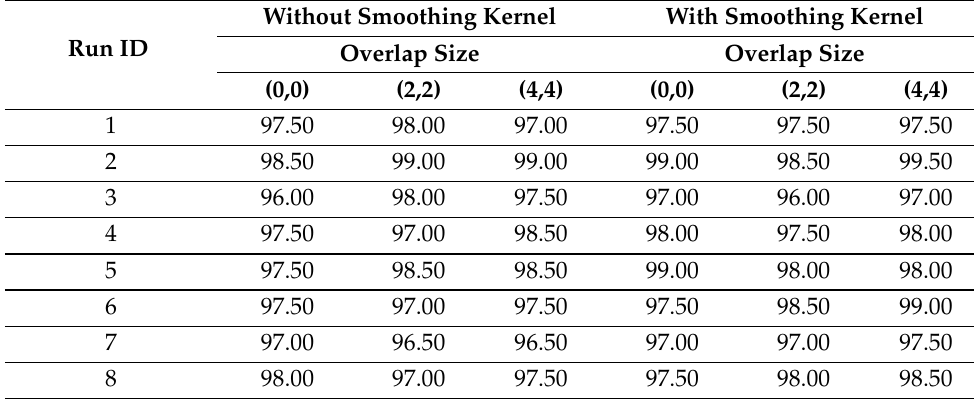
Table A6. The results of the runs for noise-free